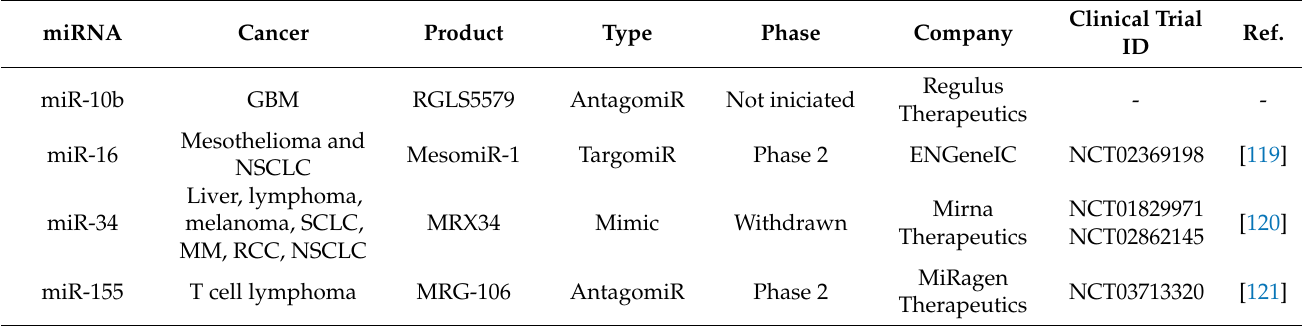
Table 2. Clinical trials of miRNA-based therapeutics to treat